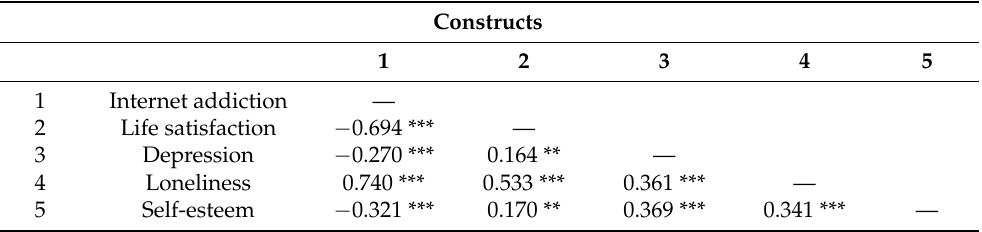
Table 4. The correlation matrix of participants’ scores of the Internet Addiction Scale, Depression Scale, UCLA Loneliness Scale, and the Life Satisfaction and Self-Esteem Scale.